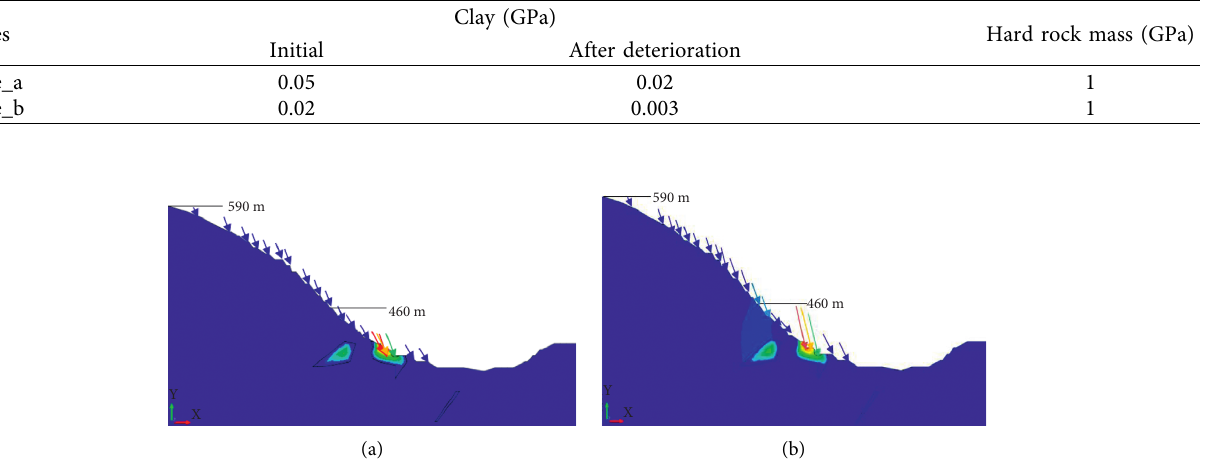
Figure 11: Total displacement vector at the surface of rock slope induced by reduction in Young’s modulus of clay, case_a (a) and case_b (b) in the blue dotted rectangle in Figure 8(b). The arrows indicate the direction of the displacement, whereas the length of the arrow is proportional to the magnitude of the displacement.